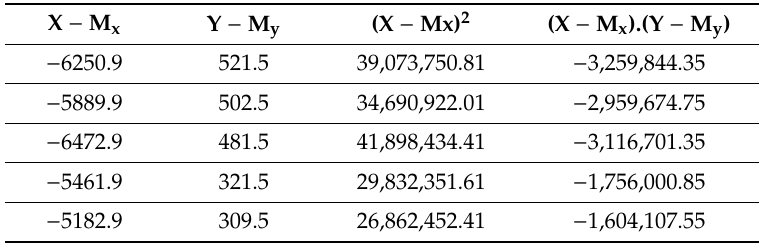
Table 1. Statistics for linear